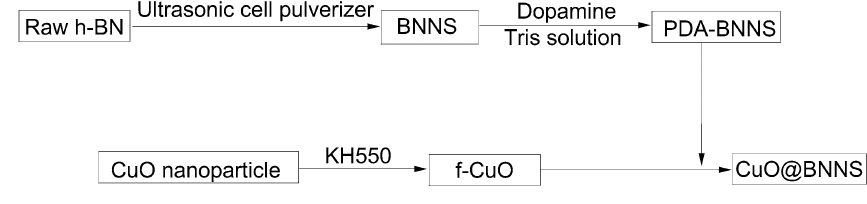
Fig.1 Preparation tactics of CuO@BNNS